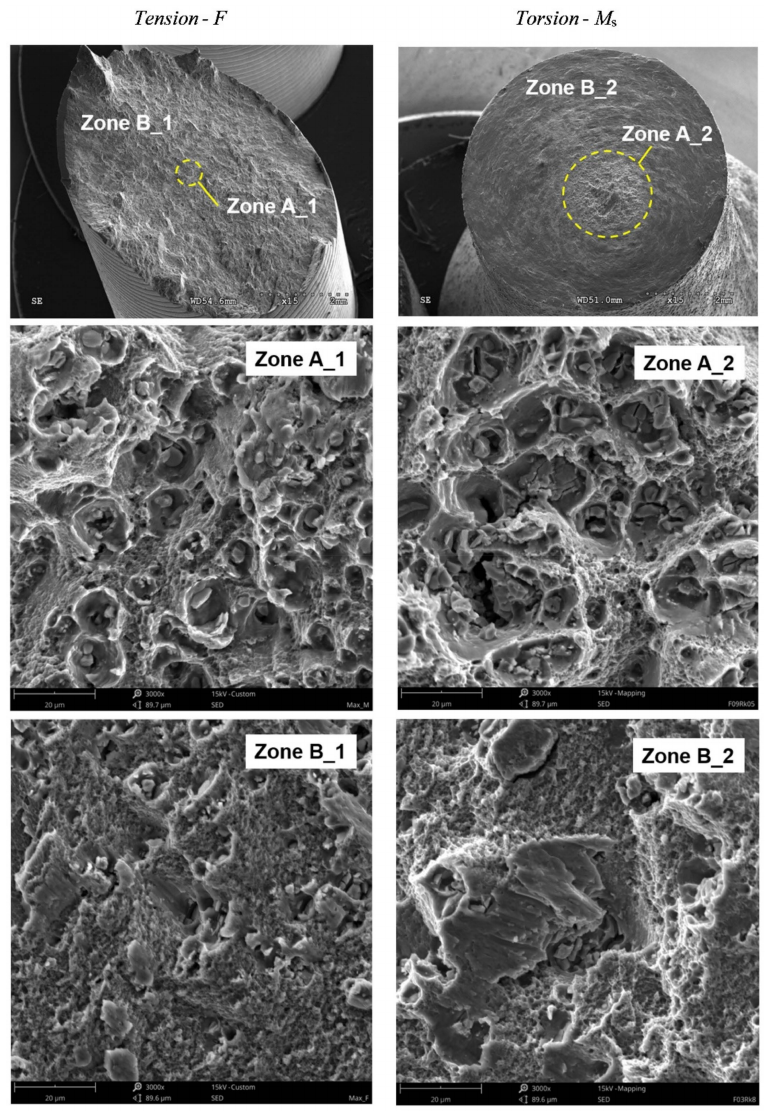
Figure 5. Fracture surface of the smooth